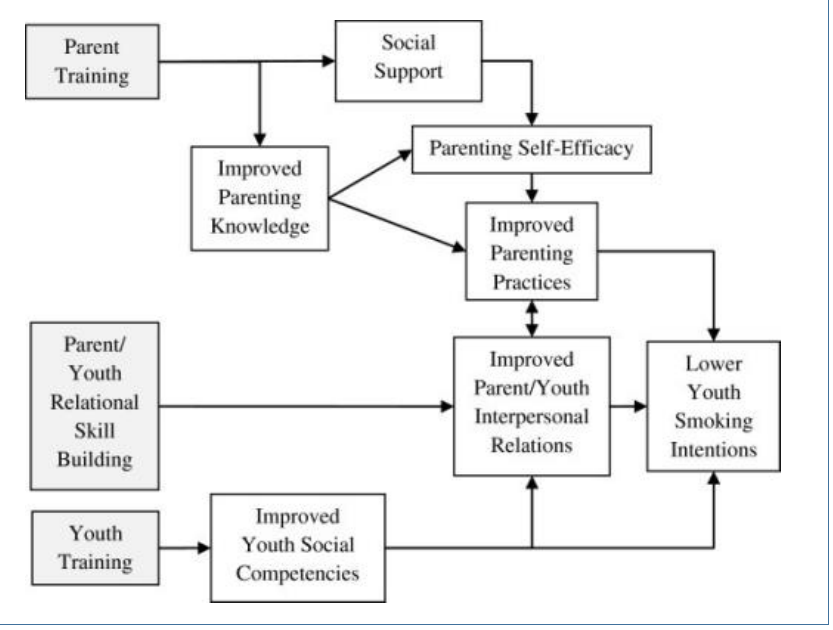
Figure 1: The Padres Informados/Jóvenes Preparados Conceptual Model (Allen et al.,